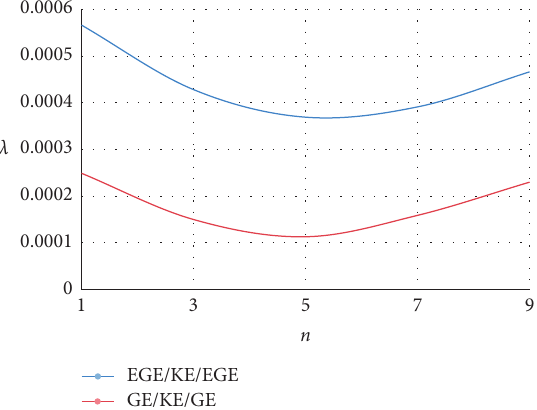
Figure 8: Relation between frequency and circumferential node number of five-layered shells 0 0 /90 0 /0 0 /90 0 /0 0 ( GE / KE / GE / KE / G E ) ; L � 0 . 5.